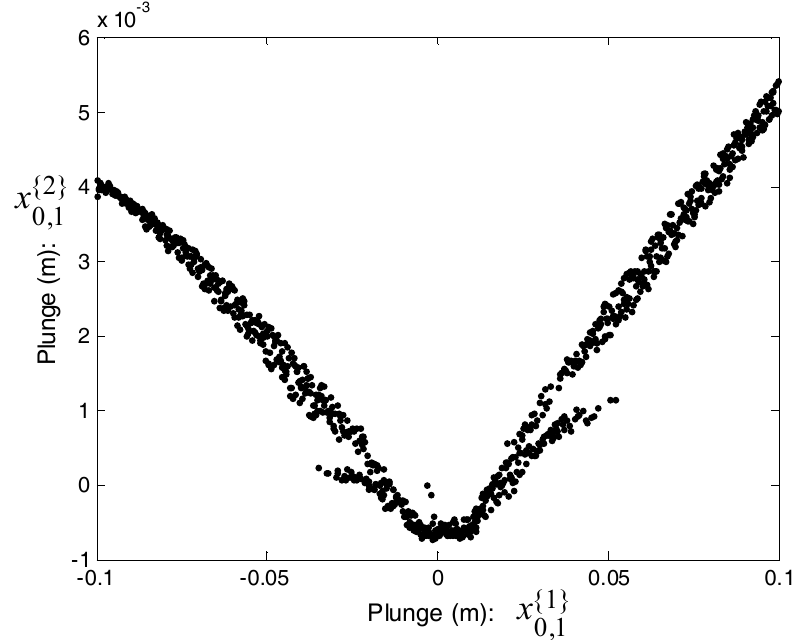
Figure 18. Iteration plot for pitch velocity in the first iteration. The airspeed is 20 m/s.